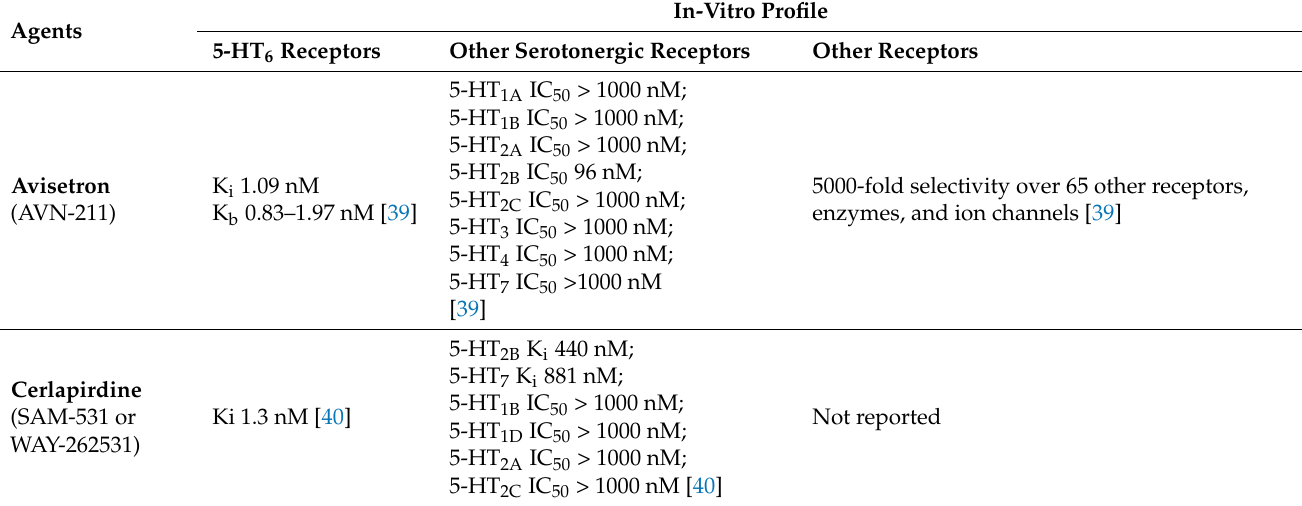
Table 1. In-vitro Profile of 5-HT 6 Receptor Antagonists in Clinical